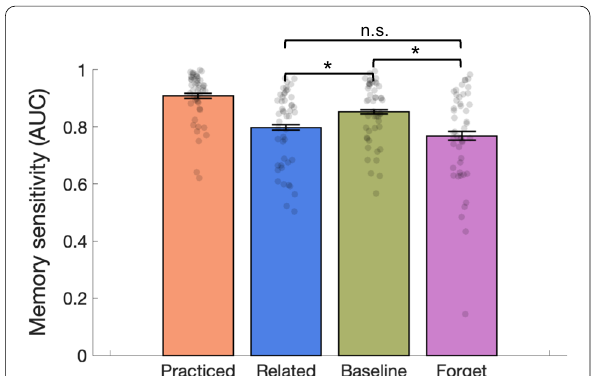
Fig. 2 Experiment 1 Results. Directed forgetting (Baseline—Forget) and recognition-induced forgetting (Baseline—Related) were both significant. Error bars are 1/ 1 within-subjects SEM −